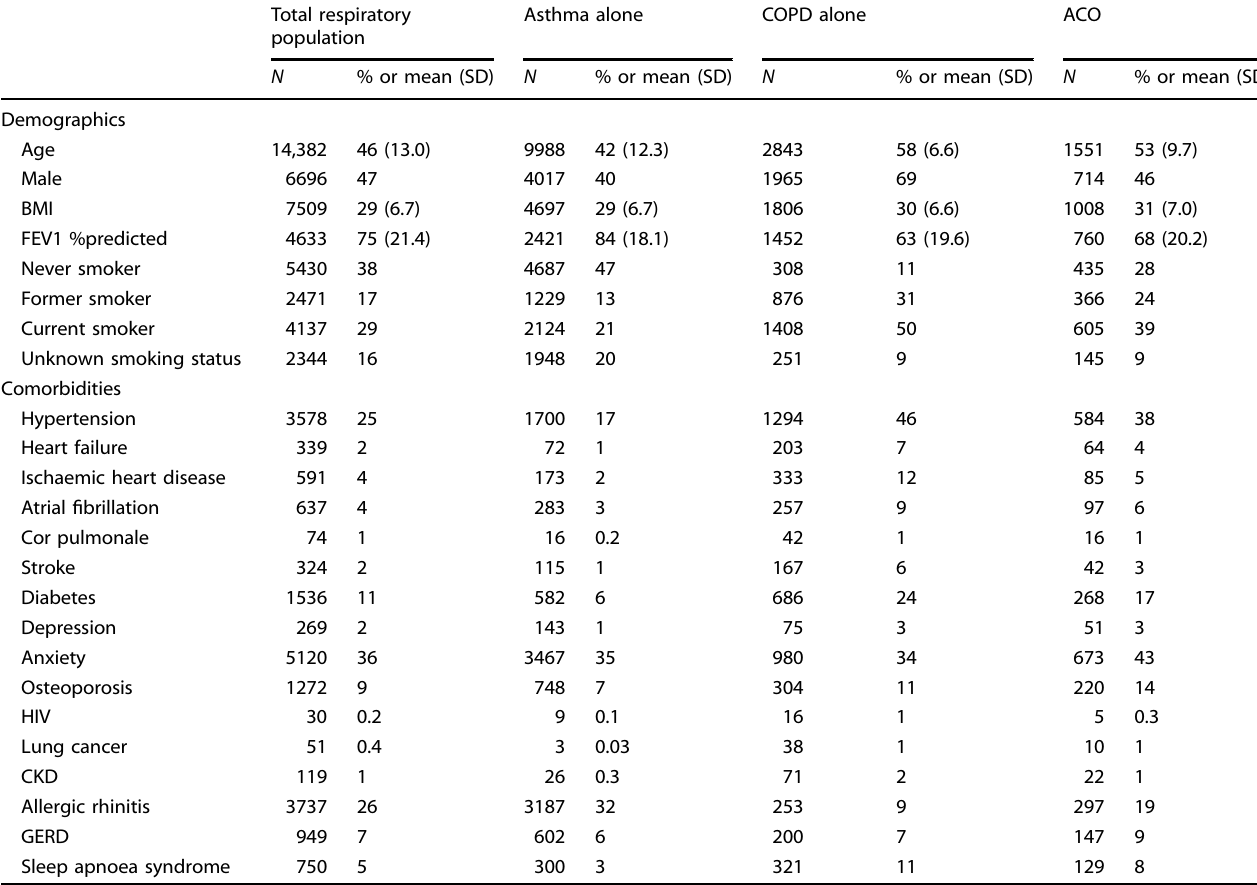
Table 1. Baseline characteristics of the Balearic asthma and/or COPD population between 19 and 65 year-old ( n =